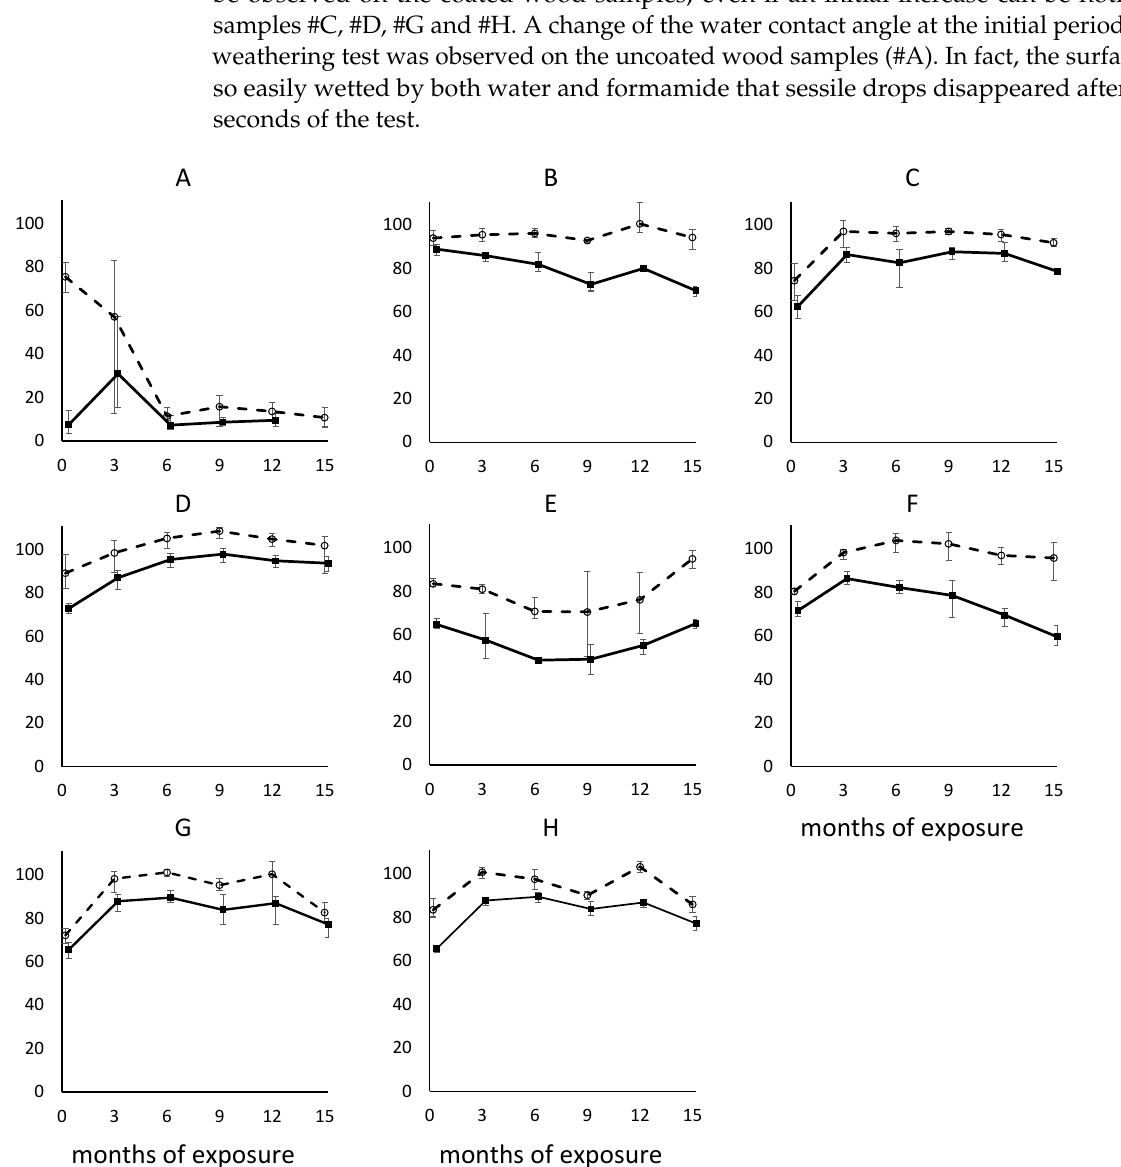
Figure 5. Contact angle measured after 3 s of wetting with water (white circle) and formamide (black square). A–H: sample